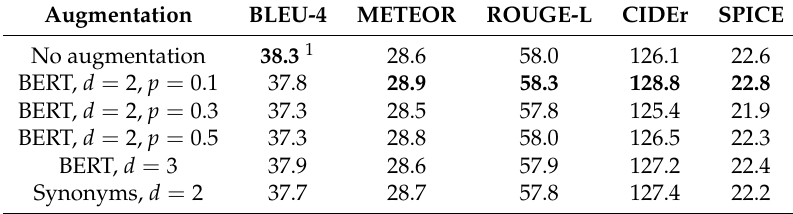
1 The best result for each metric is marked with bold.